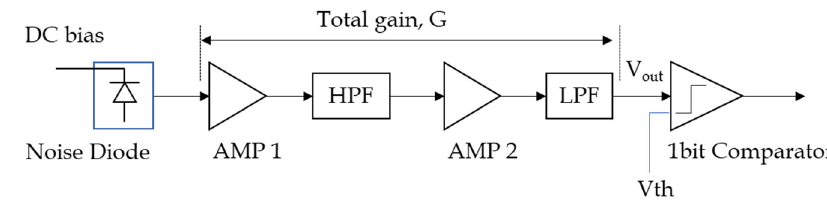
Figure 3. Baseband true noise generation block.